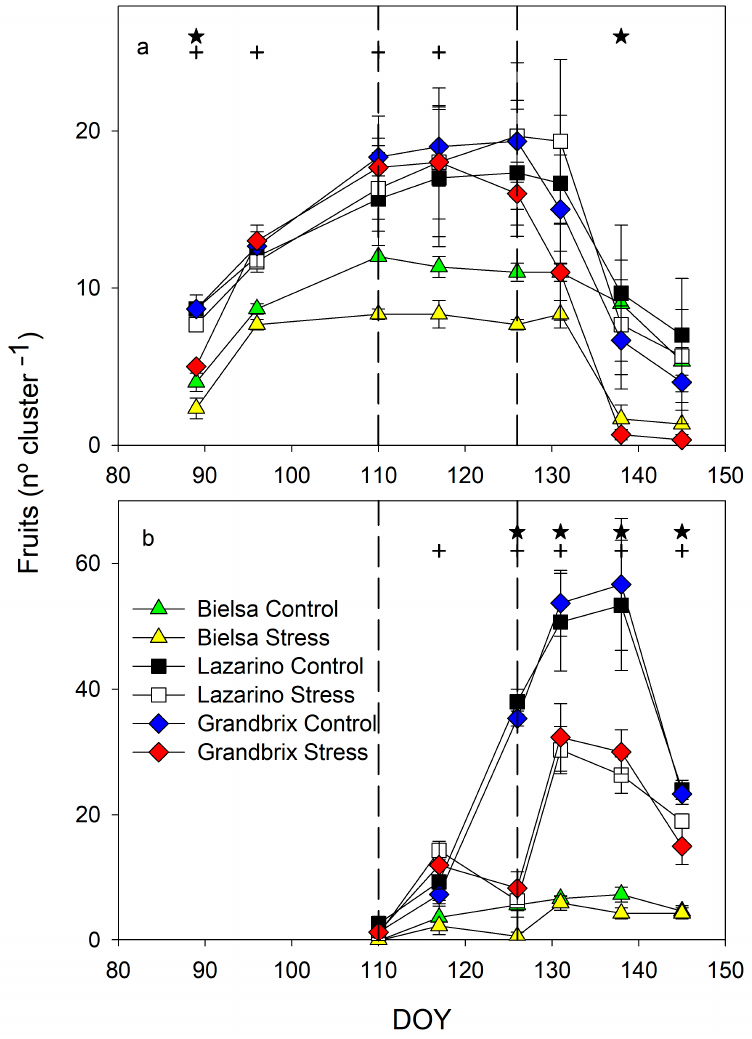
Figure 7. Pattern of fruit per cluster in the ( a ) first and ( b ) fifth cluster during the spring experiment. Each symbol is the average of 3 data. Vertical bars represent the standard error. Vertical lines limit the water stress period. Asterisks (irrigation treatments) and crosses (cultivars) indicate the date when significant differences were found ( p < 0.05).